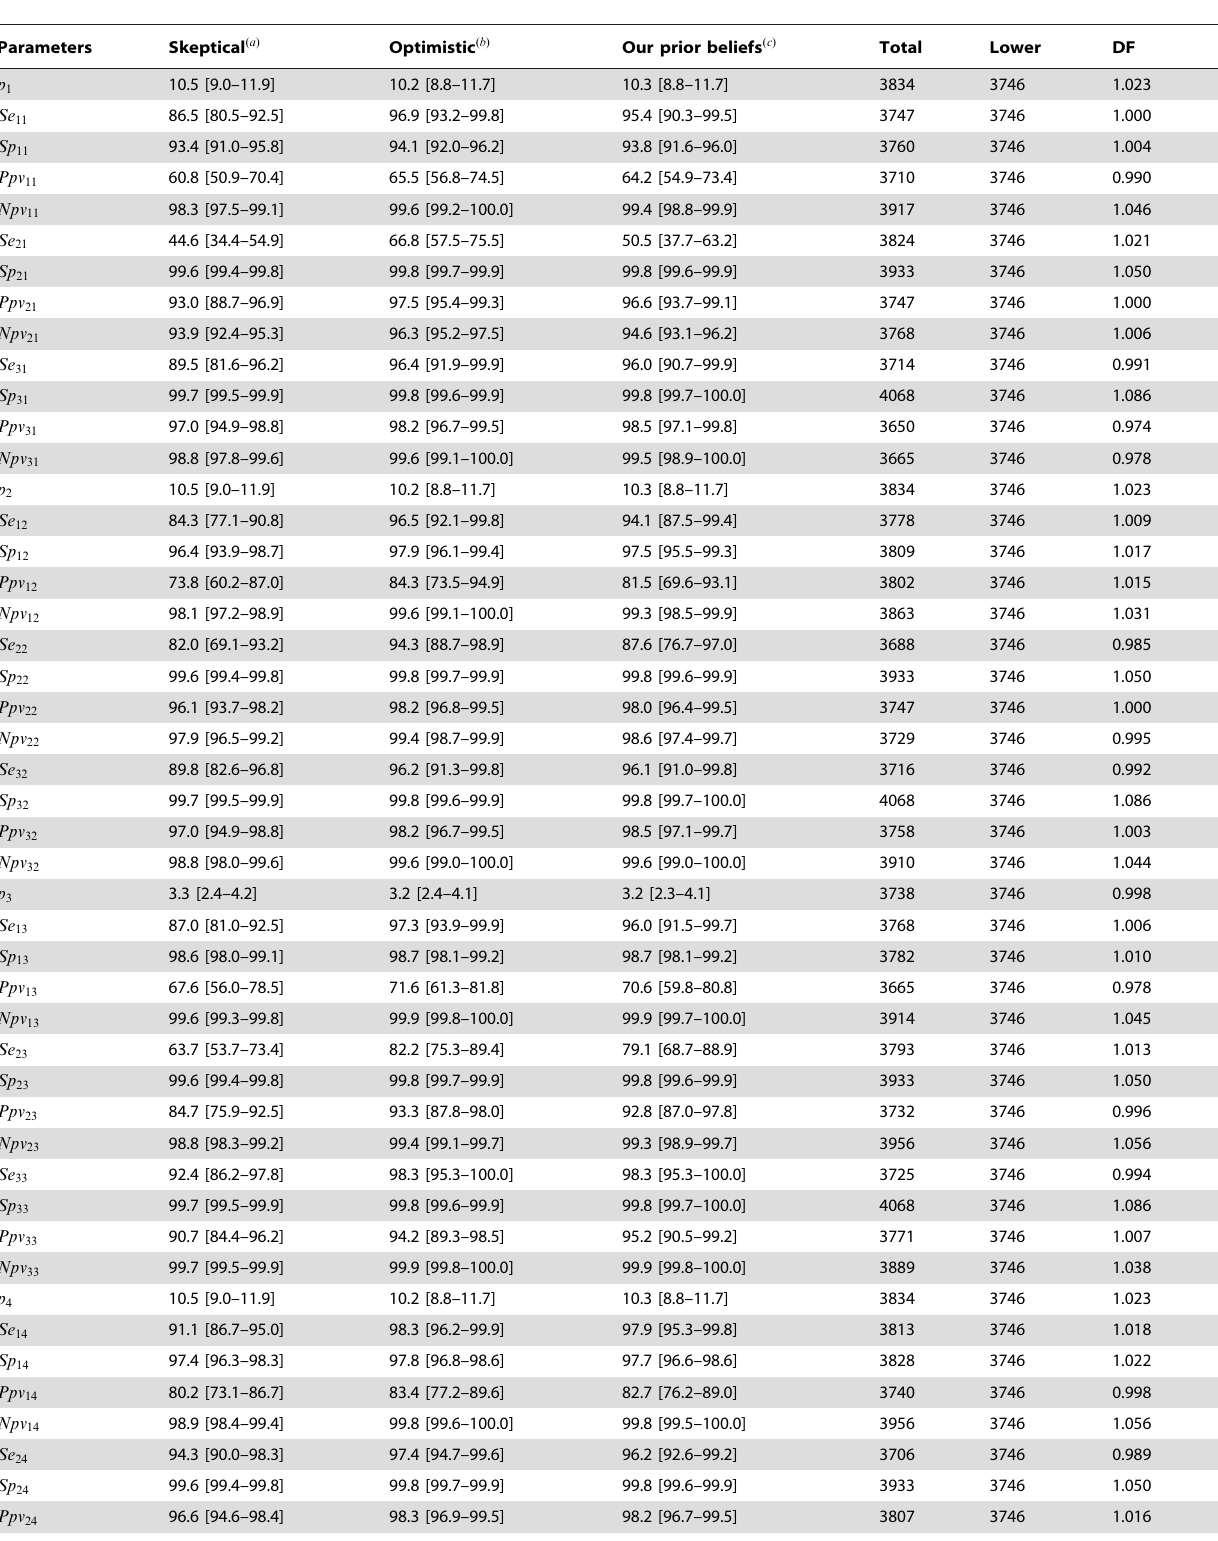
Table 7. Bayesian estimates of the malaria infection prevalence, sensitivities, specificities and predictive values, given by posterior means and 95% HPD intervals - Mean [95% HPD] - by age groups and fever status, using skeptical, optimistic and our prior distributions to